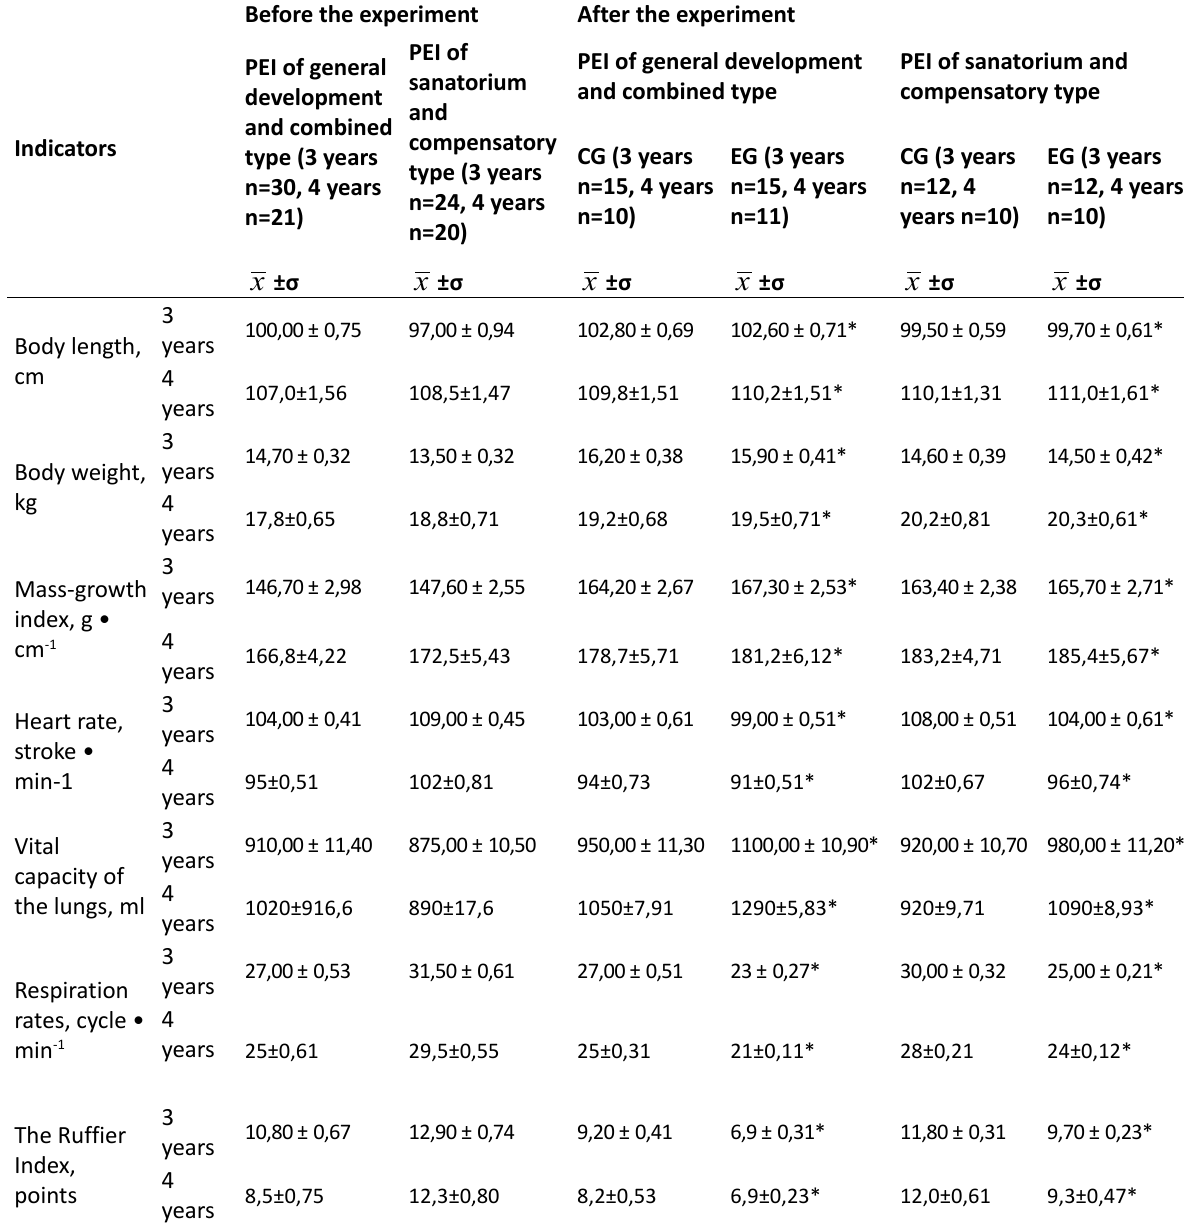
Table 3. Parameters of the morphofunctional state of girls of 3 and 4 years of control and experimental groups